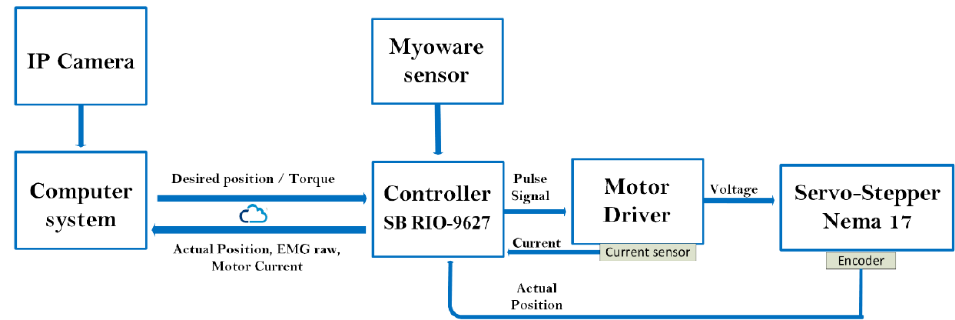
Figure 8. Wrist joint control.